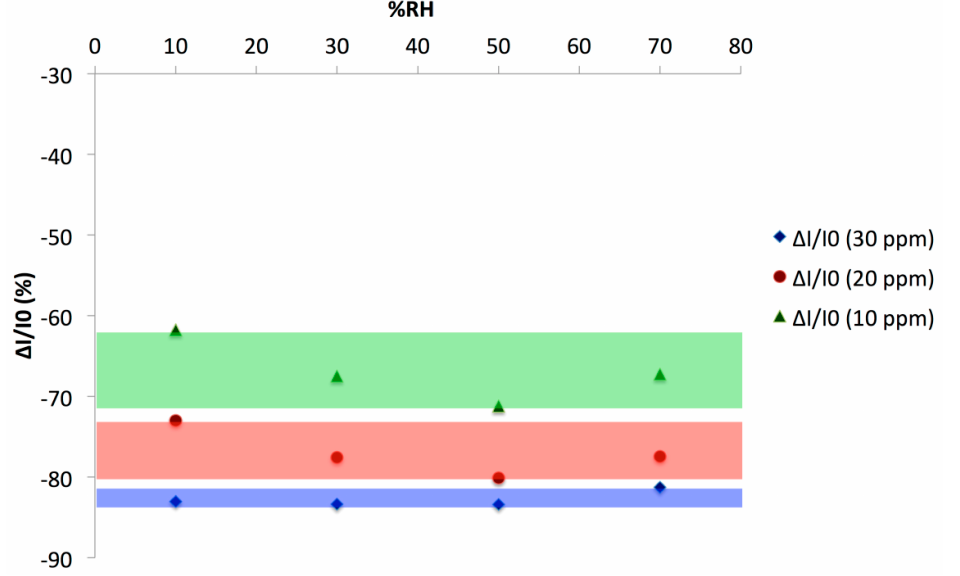
why the exposure/recovery protocol was adapted, from 1 min exposure and 4 min recovery down to 0.5 and 0.25 min exposure and 2 and 1 min recovery, respectively (Figure 14). Figure 13. Relative response (ΔI/I ) of a (PANI/CuTsPc) device (E5) to ammonia against 0 20 the Relative Humidity, as calculated from four 1 min/4 min exposure/recovery cycles. From bottom to top, the ammonia concentration is 30, 20 and 10 ppm. The green, red and blue bands show the range of the relative response for 10, 20 and 30 ppm, respectively.